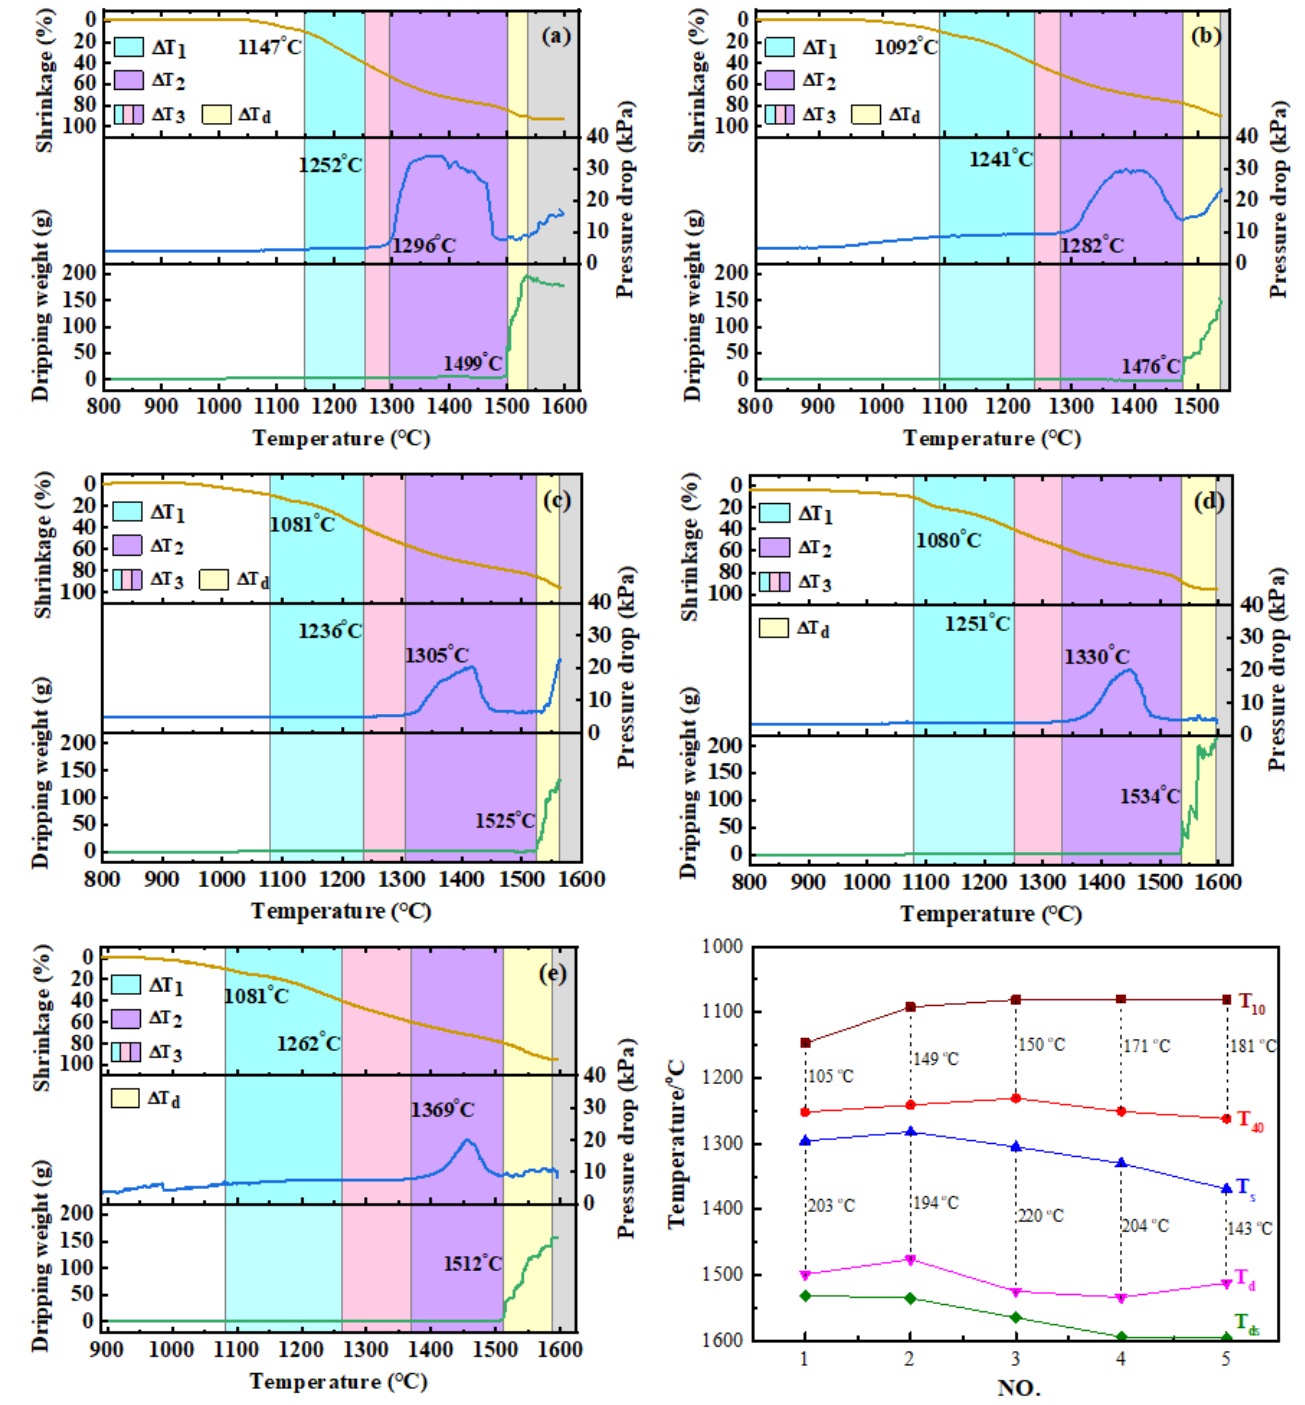
Figure 2. Softening–melting performance of burden under different conditions. ( a ) NO.1, ( b ) NO.2, ( c ) NO.3, ( d ) NO.4, ( e ) NO.5), ( f ) Characteristic Table 4. The results of softening–melting experiments.